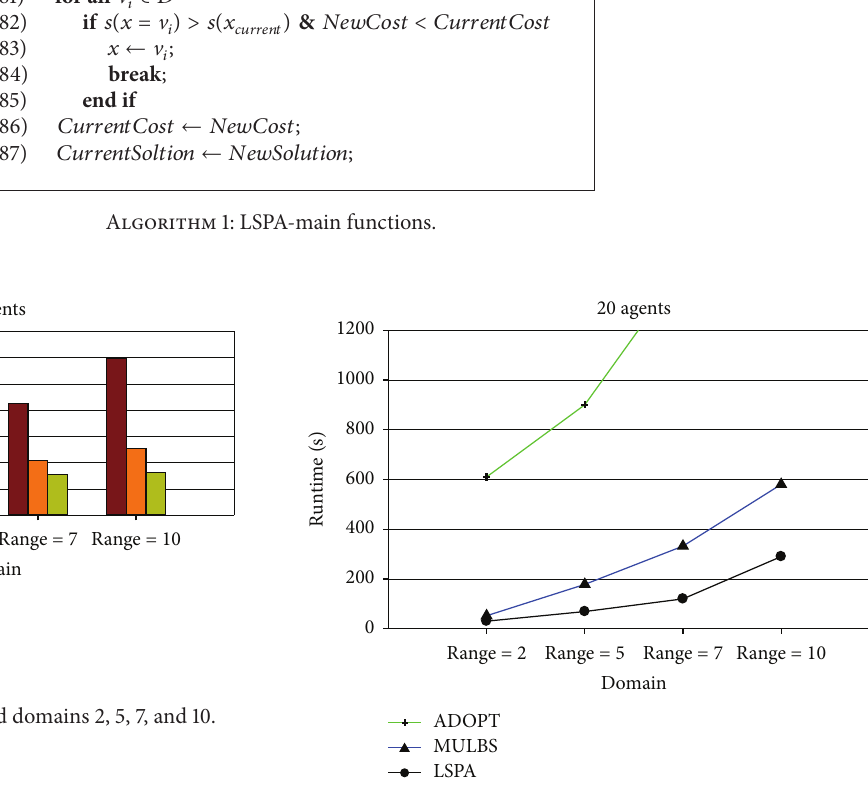
Figure 13: Runtime with density 3 and domains 2, 5, 7, and